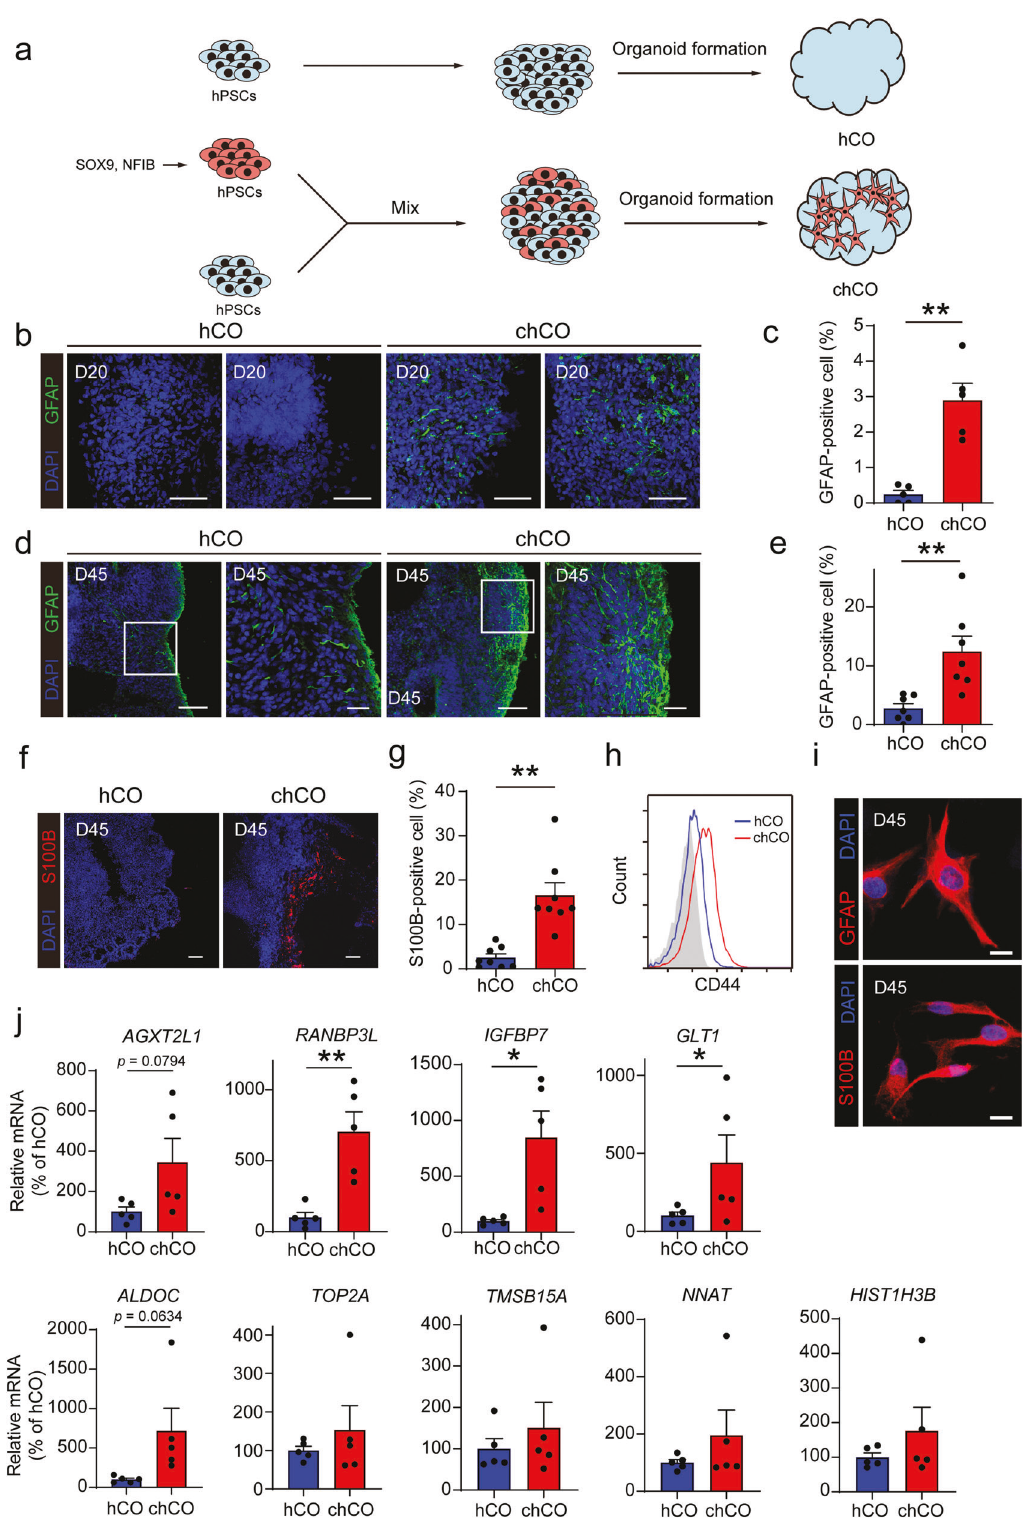
astrocytic APOE4 , we generated four kinds of chCOs with different APOE genotypes in neurons and astrocytes by mixing NFIB/SOX9 virus-infected and noninfected APOE3 or APOE4 iPSCs (Fig. 3a). The percentage of MAP2 + and GFAP + cell was similar between differentiation kinds of chCOs, indicating that